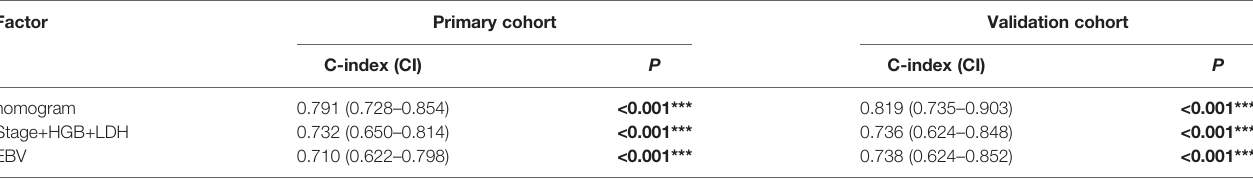
TABLE 5 | The C-indices of nomograms, TNM stage + HGB + LDH, and combined pre- and post-NACT EBV DNA for the prediction of the progression-free survival (PFS) in the primary cohort and validation cohort. Factor Primary cohort Validation cohort C-index (CI)